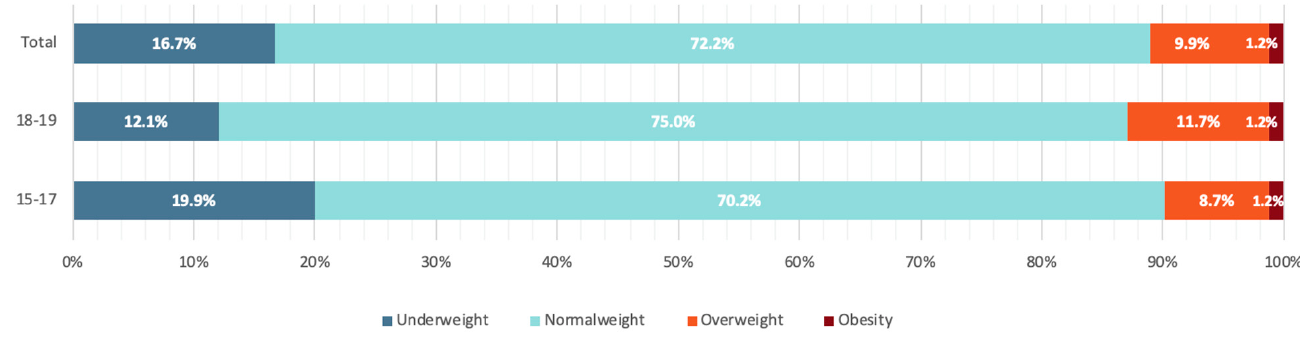
Figure 1. Distribution of BMI categories among male students’ population.